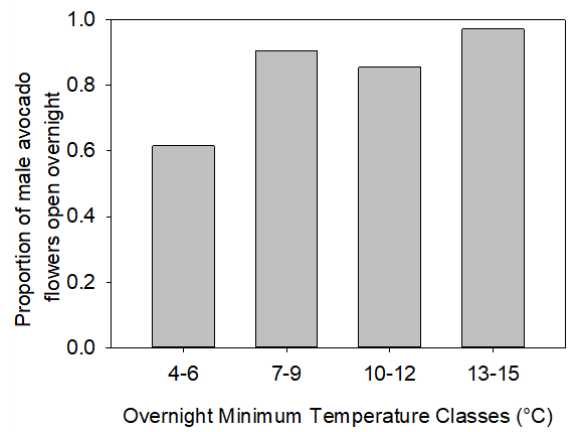
F IGURE 4: The relationship between overnight minimum temperature ranges and the proportion of male ‘Hass’ avocado flowers that remained open overnight. Temperatures are grouped into classes, each encompassing a range of